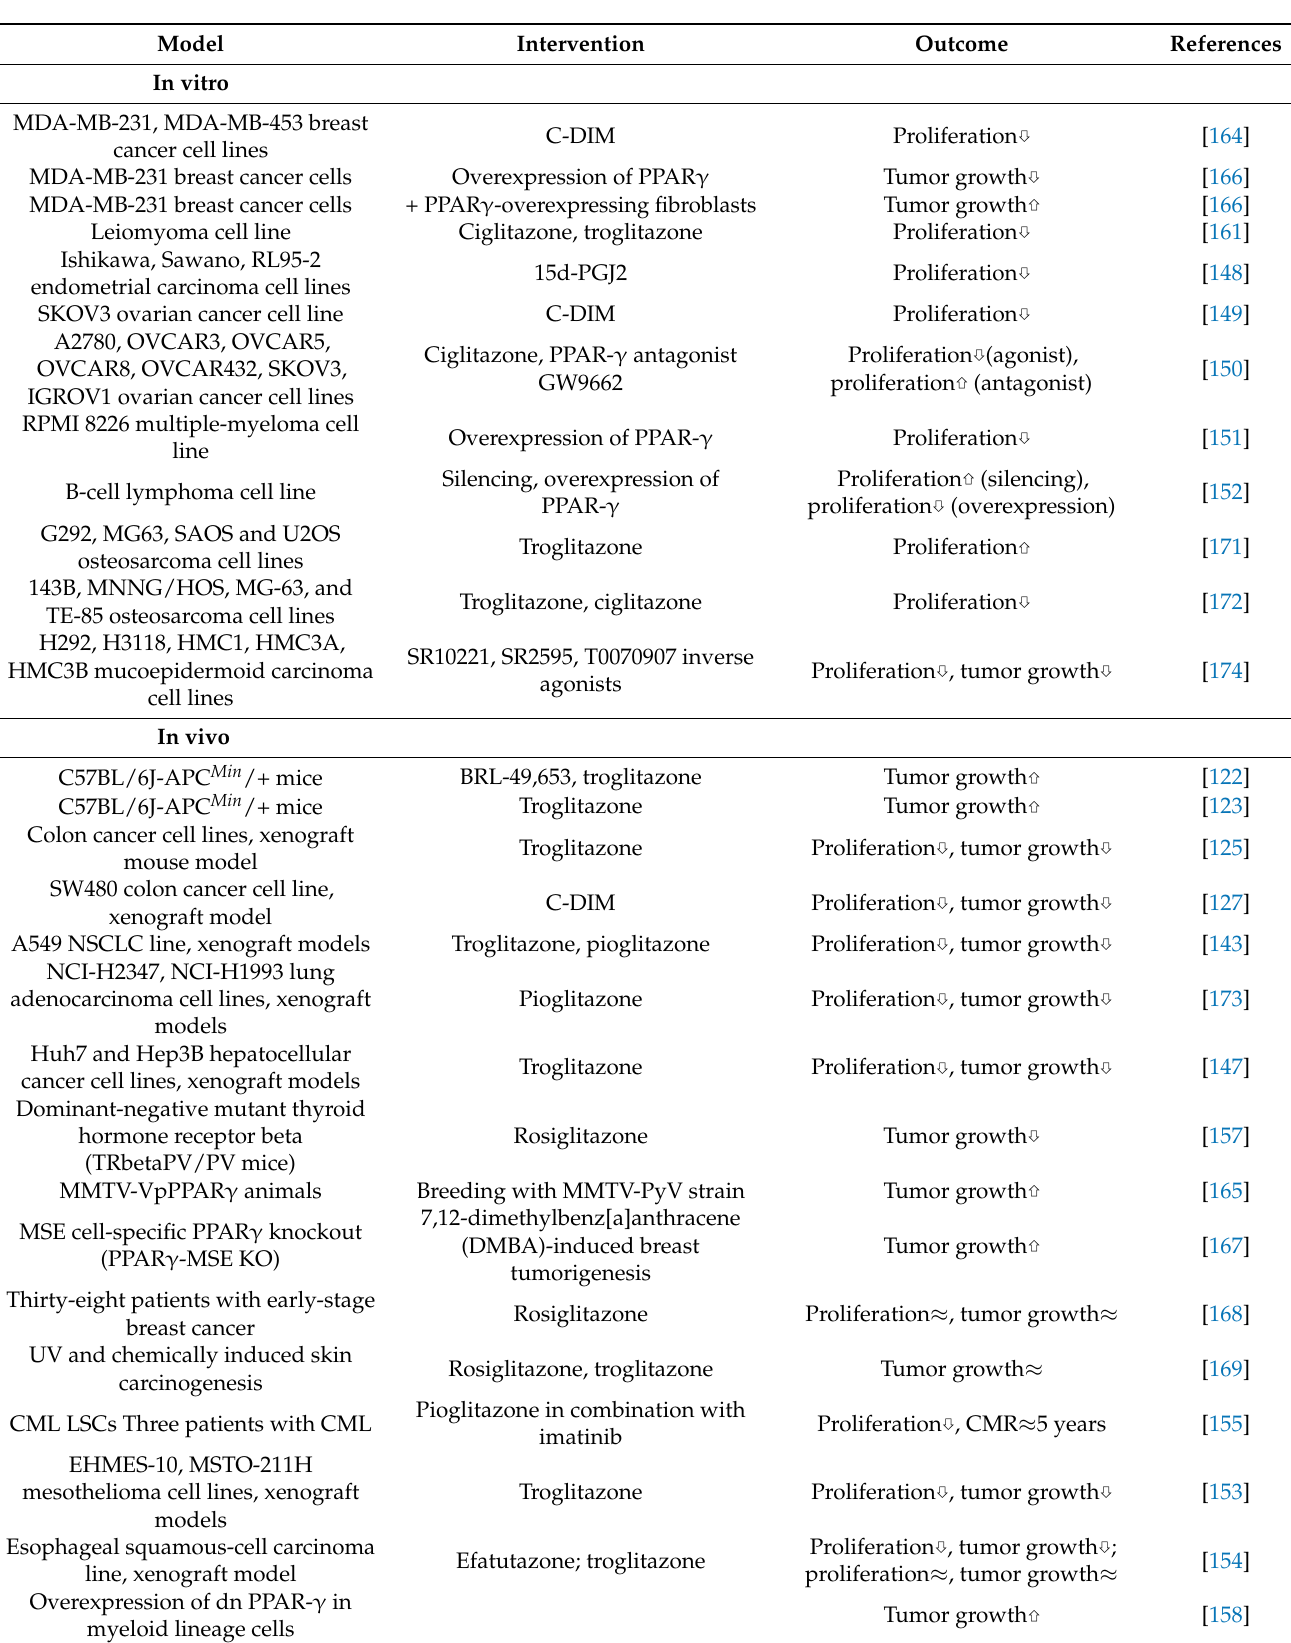
Table 1. Effects of PPARα on cell proliferation and tumor growth.